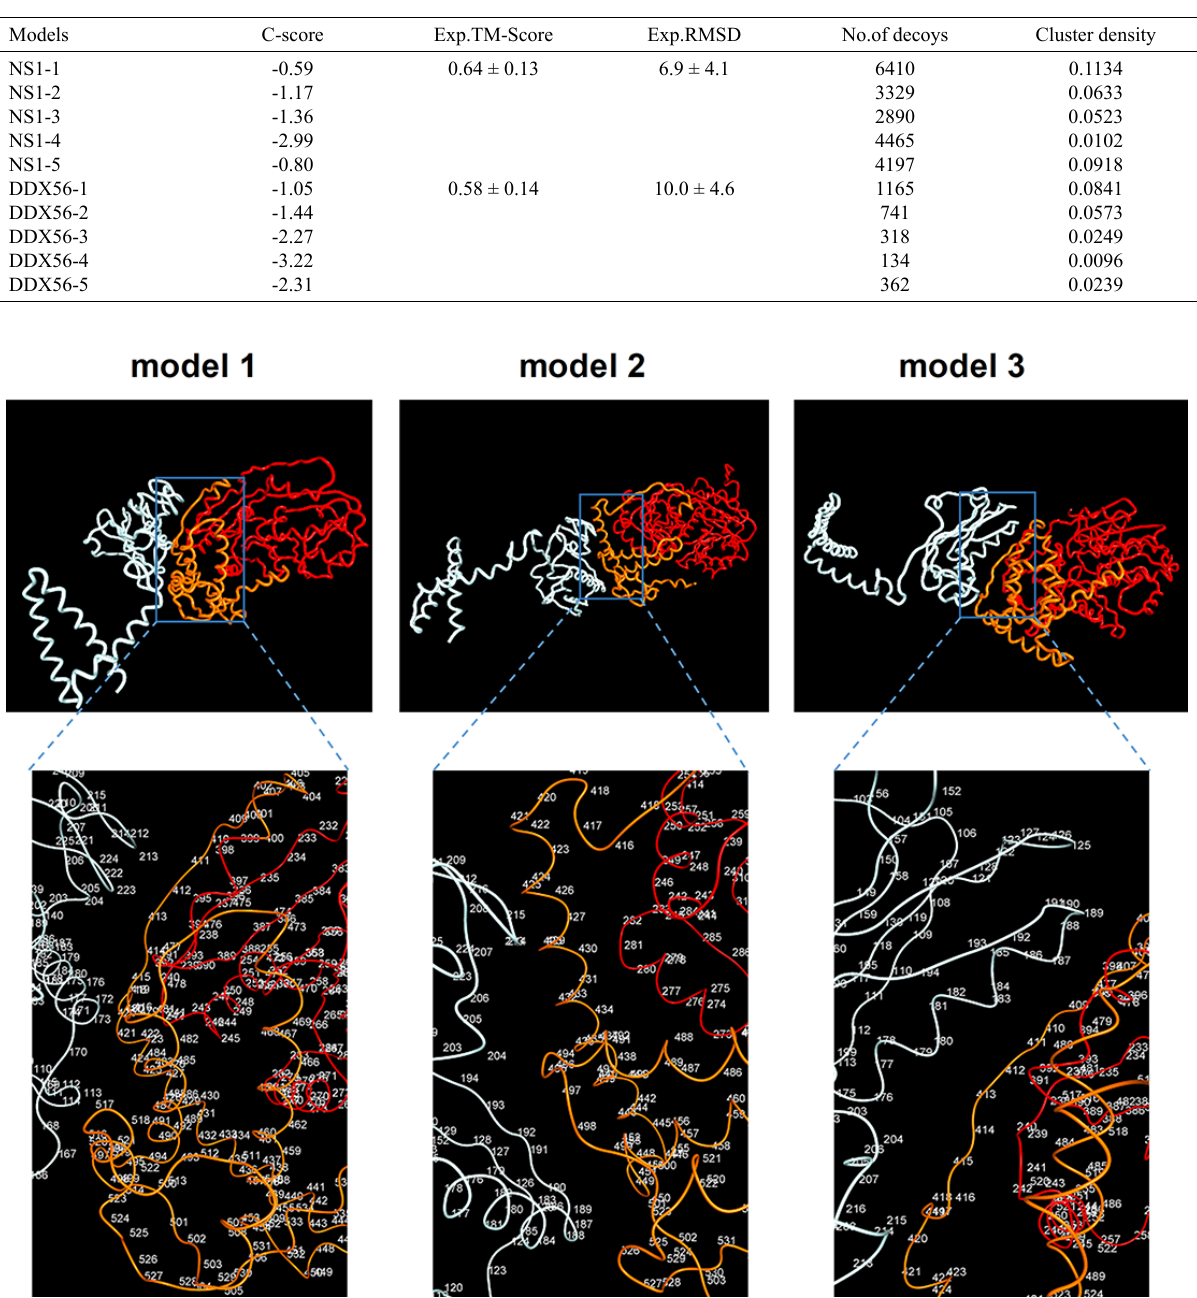
Figure 5 – In silico models of the influenza A virus NS1 and human DDX56 protein interaction. The predicted ternary structures of NS1(white) and human DDX56 (red and orange) proteins are shown. In the lower panel, the predicted interface of NS1 and DDX56 proteins are given as enlarged and numbered amino acid residues. The 3D-structures and the interaction models of the proteins were obtained using I-TASSER algorithm and Pymol software, respectively. The Gibbs free energy of binding (∆G) for interactions: -56.267 (model 1), -50.429 (model 2), -47.185 (model